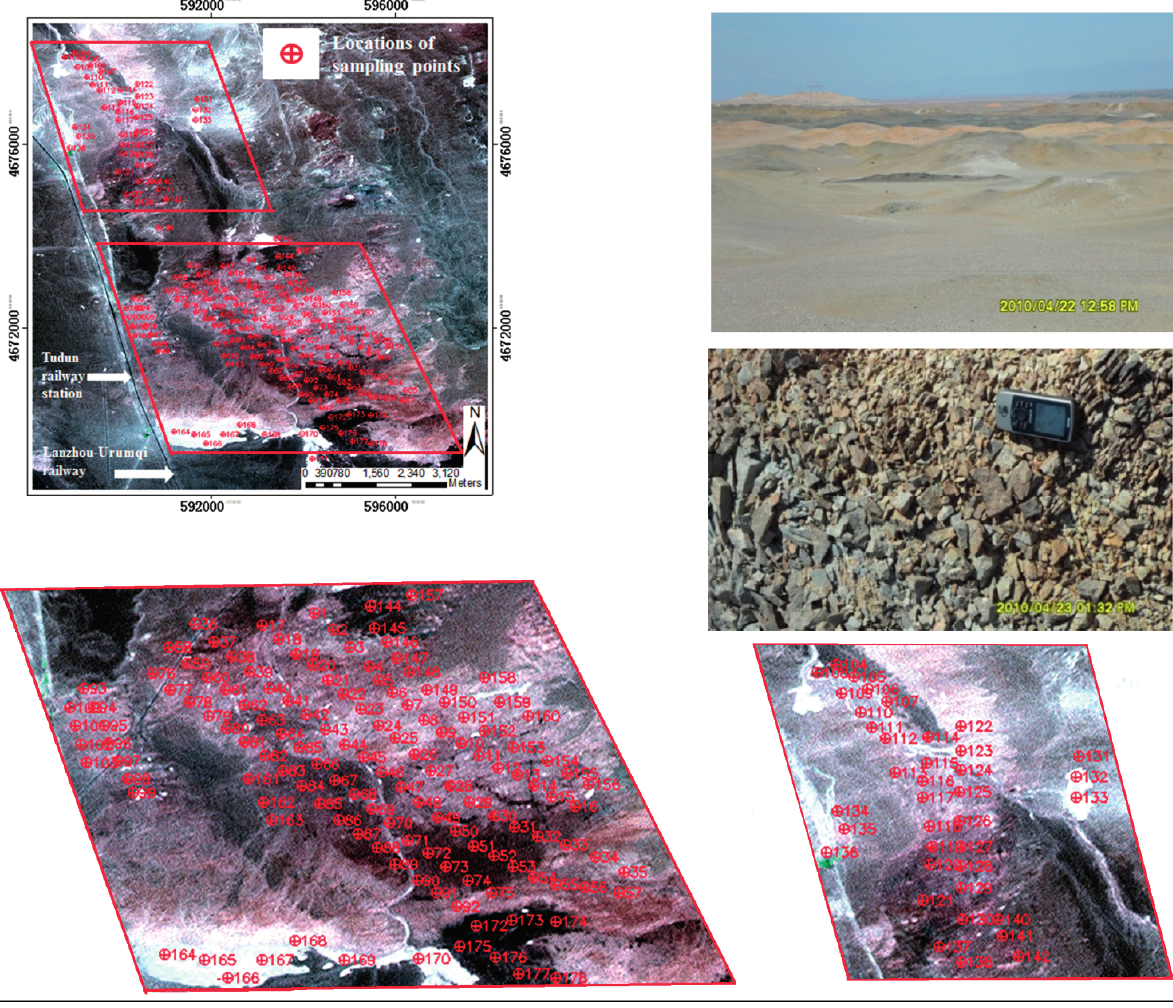
Table 4. Considering the accuracy of the PIMA and the impacts of environmental factors on